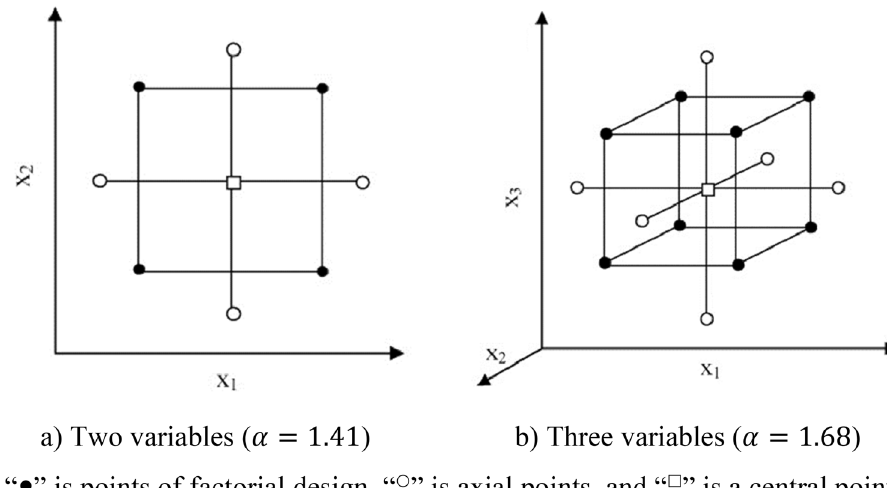
Figure 4. Schematic view of CCD for optimization of two and three variables.